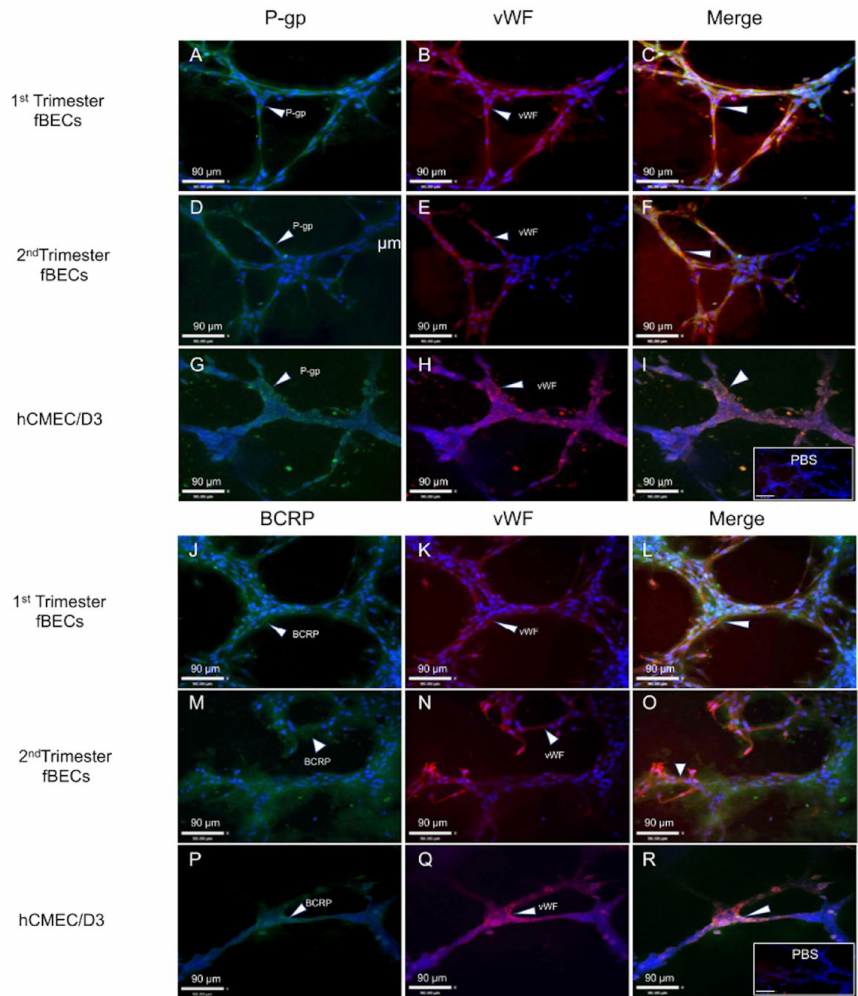
Figure 3. P-glycoprotein (P-gp), breast cancer resistance protein (BCRP) and von Willebrand fac- tor (vWF) are expressed by capillary-like tube structures formed by early and mid-gestation pri- mary human fetal brain endothelial cells (hfBECs). Representative immunofluorescence images of P-gp ( A , D , G ) BCRP ( J , M , P ) and vWF ( B , E , H , K , N , Q ) in early gestation ( A – C , J – L ), and mid-gestation ( D – F , M – O ) hfBECs and in the adult endothelial cell line hCMEC/D3 (as positive control) ( G – I , P – R ). Arrows indicate P-gp, BCRP and vWF staining within capillary-like tube structures. Expression of vWF (red) confirmed the endothelial cell phenotype. P-gp and BCRP (green) and vWF (red) staining co-localize (yellow) inside the capillary-like tube structures. Insets (bottom right) in ( I , R ) represent PBS as the negative control. Sections were counter-stained with DAPI (blue; a nuclear marker). n = 4/gestational age (representative images presented). Scale bars = 90